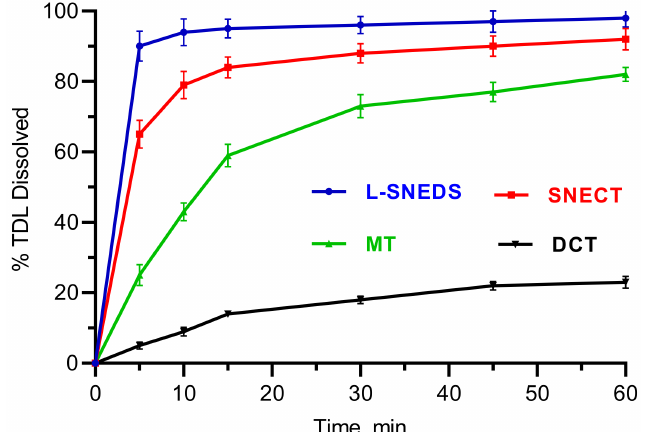
Figure 8. In vitro dissolution profiles tadalafil from liquid self-nanoemulsifying drug delivery sys- tems (L-SNEDDS), self-nanoemulsifying chewable tablets (SNECT), marketed tablets (MT), and direct compressed tablets (DCT).